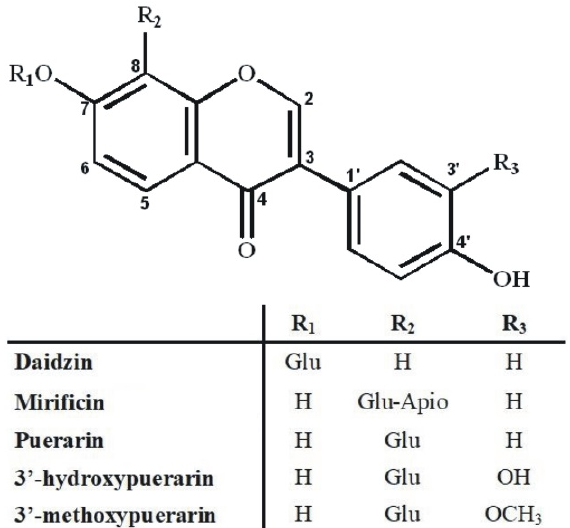
Figure 2. Molecular structure of polar isoflavone derivatives identified in the kudzu lyophilisate.